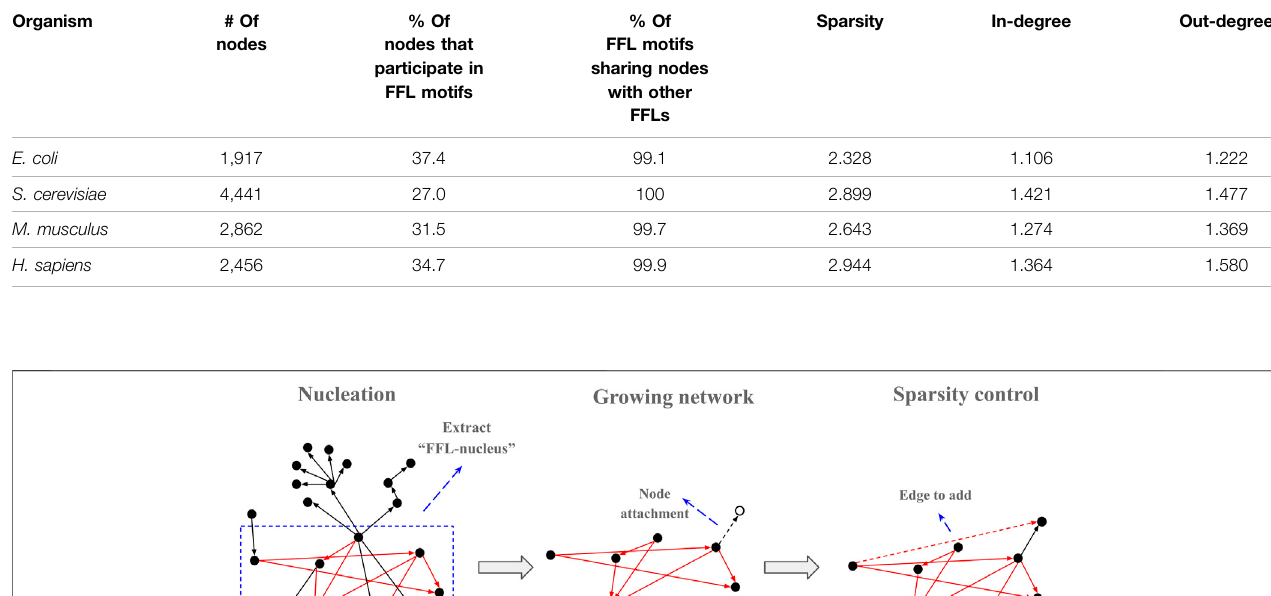
Frontiers in Genetics |